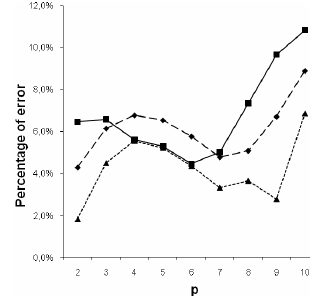
Figure 6. Optimality error for 40 aggregated